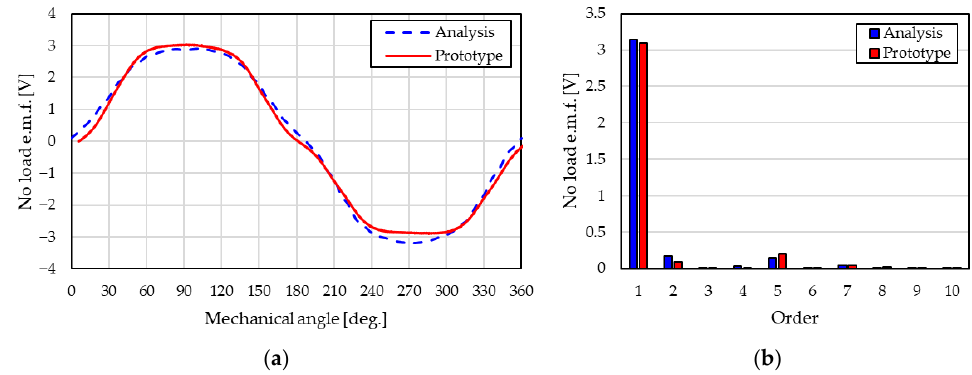
Figure 22. U-phase back e.m.f. at 1000 r/min: ( a ) waveforms; ( b ) FFT results.